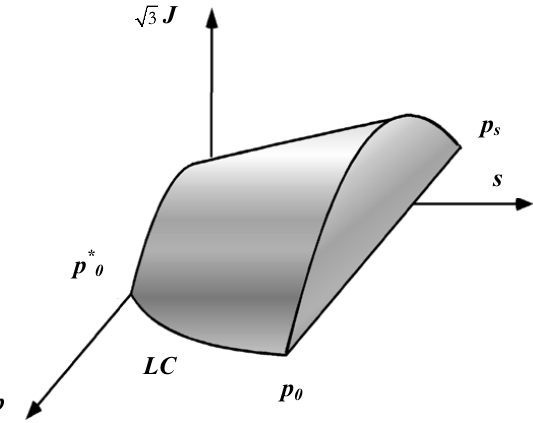
Fig. 6 – A three-dimensional representation of the BBM yield surface.